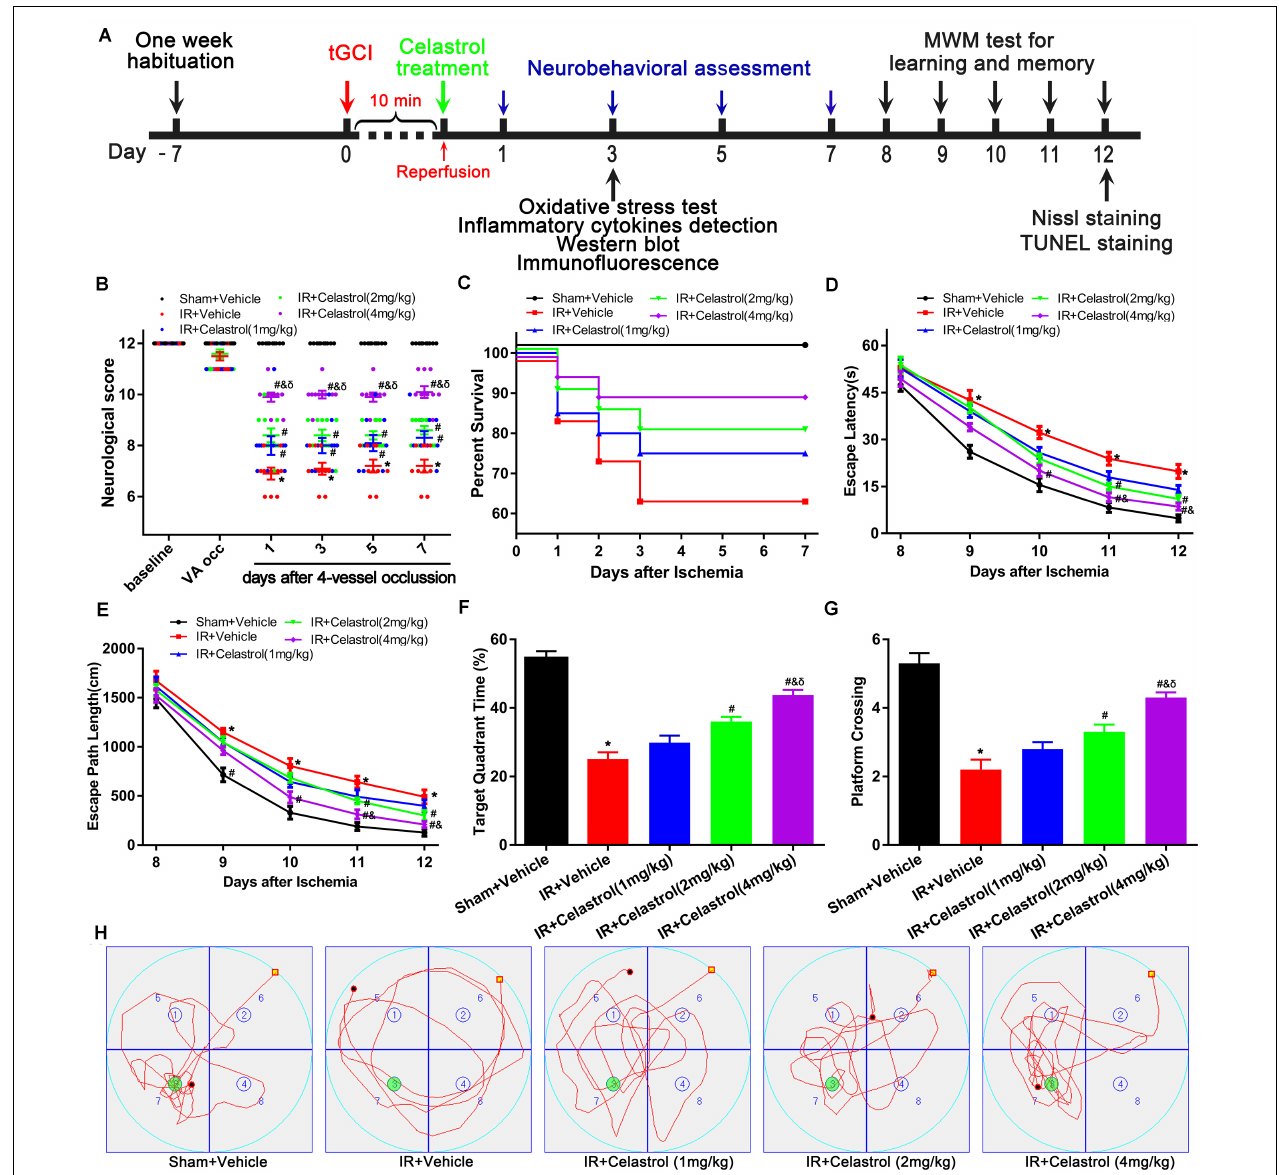
FIGURE 1 | Experimental design and effect of celastrol treatment on ischemia induced neurobehavioral deficits. (A) Schematic diagram illustrating the experimental design of drug treatment and neurobehavioral assessment of ischemic cerebral injury. Seven days after habituation, rats were subjected to transient global cerebral ischemia reperfusion (tGCI/R), celastrol or vehicle was intraperitoneally injected immediately after reperfusion. Neurological score was evaluated at 1, 3, 7 days after tGCI/R and the (Morris Water Maze test) MWM was performed to assess learning and memory 7 days after tGCI/R, samples were collected 3 or 12 days after tGCI/R for further detection. (B) Neurological score shown for individual rats at different time points ( n = 10 for each group) (Mann-Whitney- U -test). (C) Kaplan-Meier curves of animal survival for 7 days following vehicle or celastrol treatment after tGCI/R procedures. Values are expressed as percentages ( n = 15, 20, 20, 20, 20 in Sham + Vehicle, IR + Vehicle, IR + Celastrol (1 mg/kg), IR + Celastrol (2 mg/kg) and IR + Celastrol (4 mg/kg) groups, respectively). (D) Mean escape latency of rats to reach the hidden platform during the place navigation test. (E) Mean escape path length of each rats to reach the hidden platform during the place navigation test. (F) Time spend in the target quadrant during the spatial probe test. (G) The number of times that rats crossed the original platform location during the spatial probe test. (H) Representative swimming trajectories of rats during the spatial probe test, green circles indicated the location of escape platform. The error bars represent mean ± S.E.M ( n = 10, ∗ P < 0.05 vs. Sham + Vehicle group; # P < 0.05 vs. IR+ Vehicle group; & P < 0.05 vs. IR + Celastrol (1 mg/kg) group; δ P < 0.05 vs. IR + Celastrol (2 mg/kg) group).